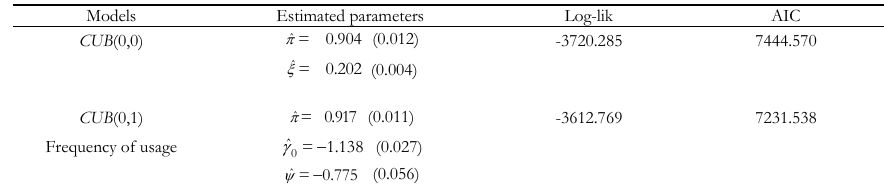
Estimated CUB models for Orientation